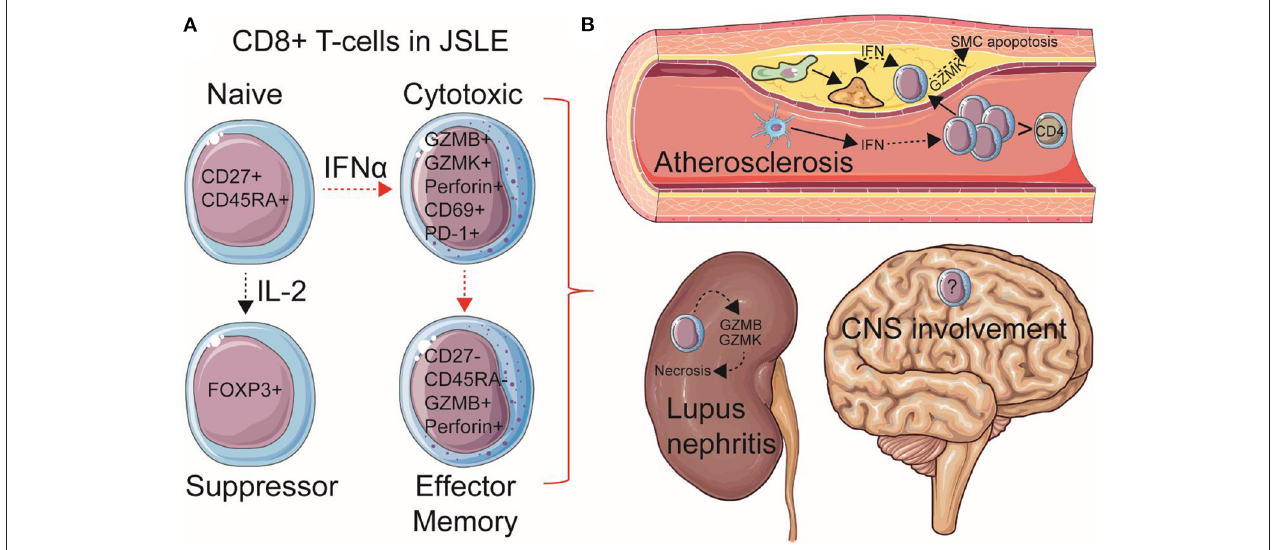
FIGURE 1 | Summary of speculated pathogenic mechanisms of CD8 + T-cells in JSLE. (A) Total and naïve CD8 + T-cell frequencies are increased in circulation in JSLE patients. CD8 + T-cell functional differences have also been described in JSLE, including high expression levels of granzyme B/K (GZMB/K) and perforin transcripts, as well as CD69 and PD-1 expression, suggesting an activated, cytotoxic, pro-apoptotic, but exhausted CD8 + T cell profile. CD8 + FOXP3 + (suppressor) T-cells have also been described in JSLE using single cell technologies. Total and effector memory (EM) CD8 + T-cells have been associated with worse disease outcomes and organ involvement in JSLE, including (B) lupus nephritis and atherosclerosis (cardiovascular disease). Speculated mechanisms of organ involvement are displayed. With this respect, it has been recently shown that CD8 + T-cells are the predominant immune cell in established human atherosclerotic plaques and that high cardiometabolic risk JSLE patients have increased pro-inflammatory and pro-apoptotic circulating CD8 + T-cells associated with type-I interferon (IFN) signaling, which could influence plaque instability through effects on macrophage (green) foam cell (yellow) formation and apoptosis of vessel smooth muscle cells (SMCs). Dotted arrows represent indirect processes, including cellular maturation/differentiation and the effects of inflammatory mediators on cell signaling. Increased central nervous system (CNS) involvement is also associated with JSLE, however, immune mechanisms are less investigated. This Figure was produced using resources